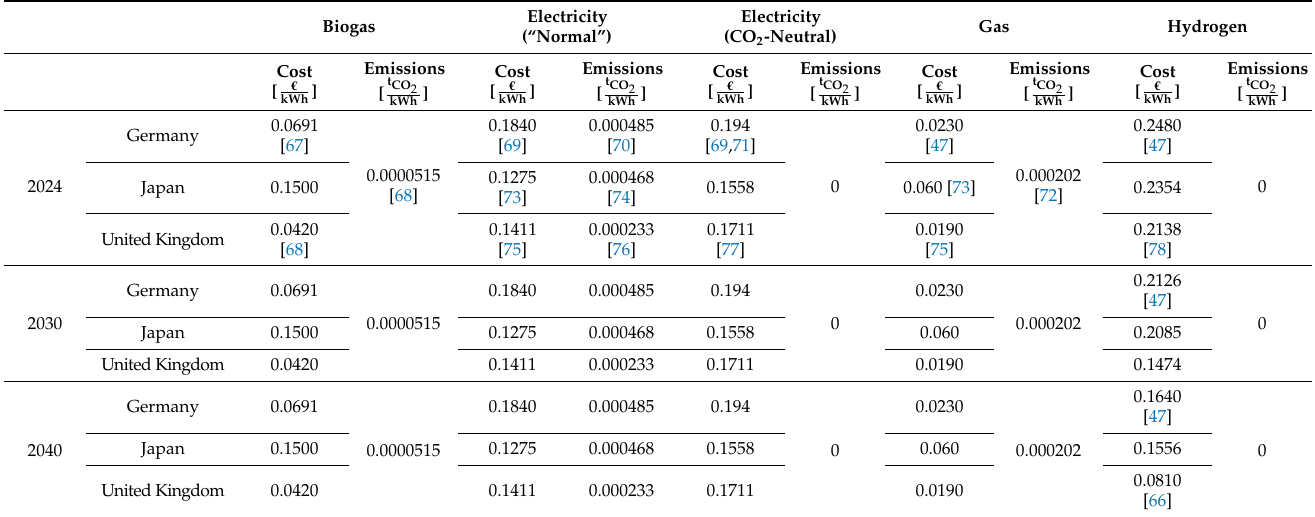
Table 3. Fuel and electricity prices.